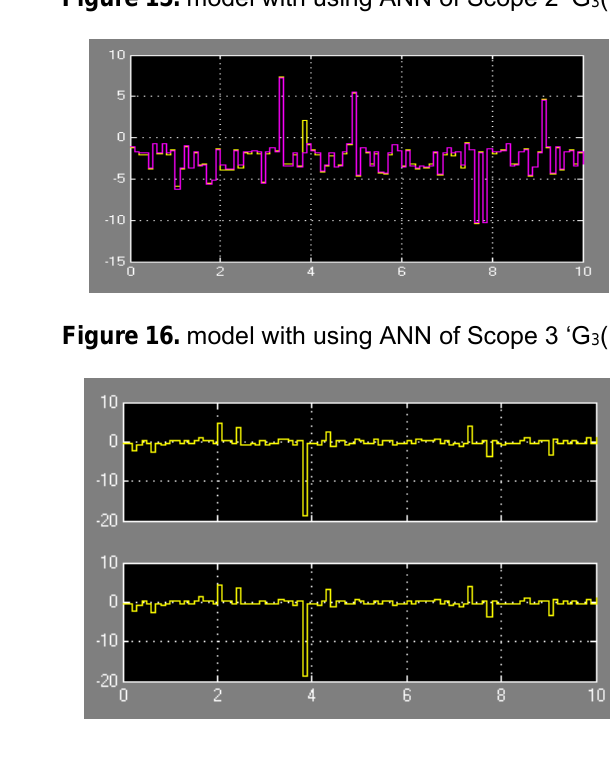
Figure 13. model with using ANN of Scope 2 ‘G 2 (u)’